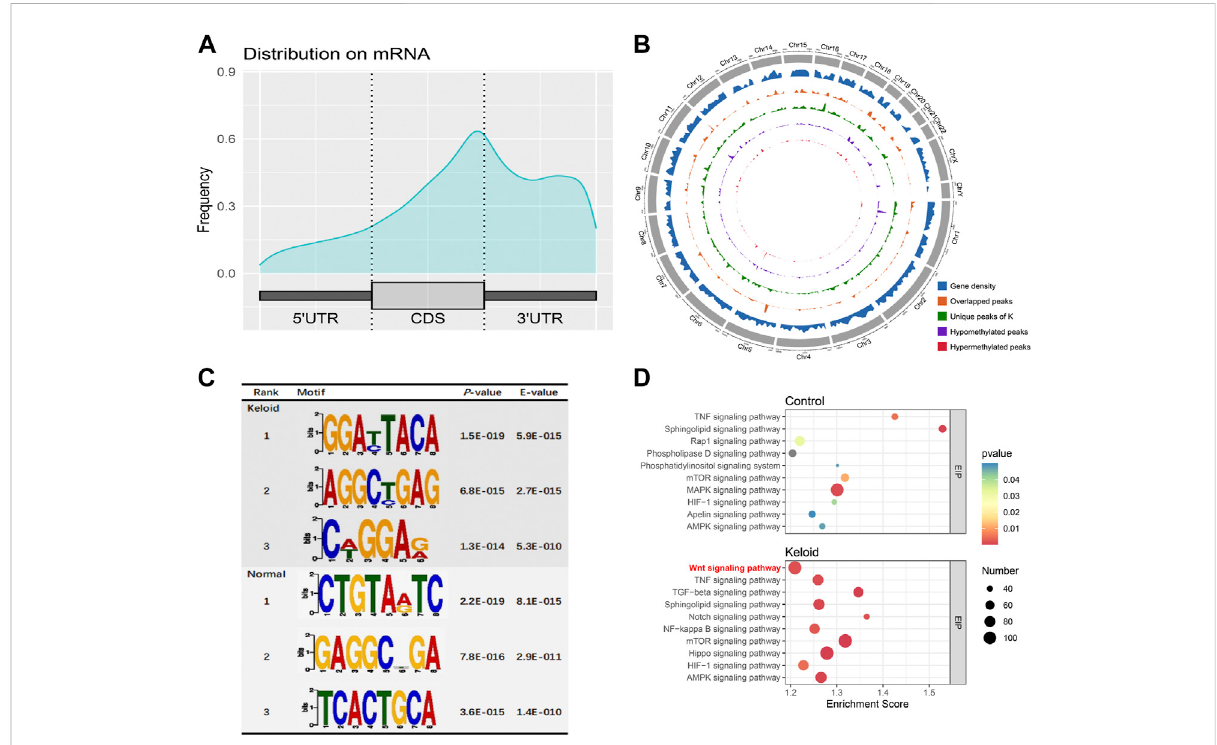
FIGURE 2 m 6 A-modi fi edtranscriptpro fi leandtheassociatedpathwayintwogroups. (A) Distributiondensityofm 6 Apeaksinthe5 ′ -UTR,codingsequence (CDS), and 3 ′ -UTR regions. (B) Density distribution of the m 6 A peaks on the 24 chromosomes. (C) Top three sequence motifs in two tissues. (D) Top 10 signi fi cantly enriched pathways of m 6 A-methylated genes in keloid and NS